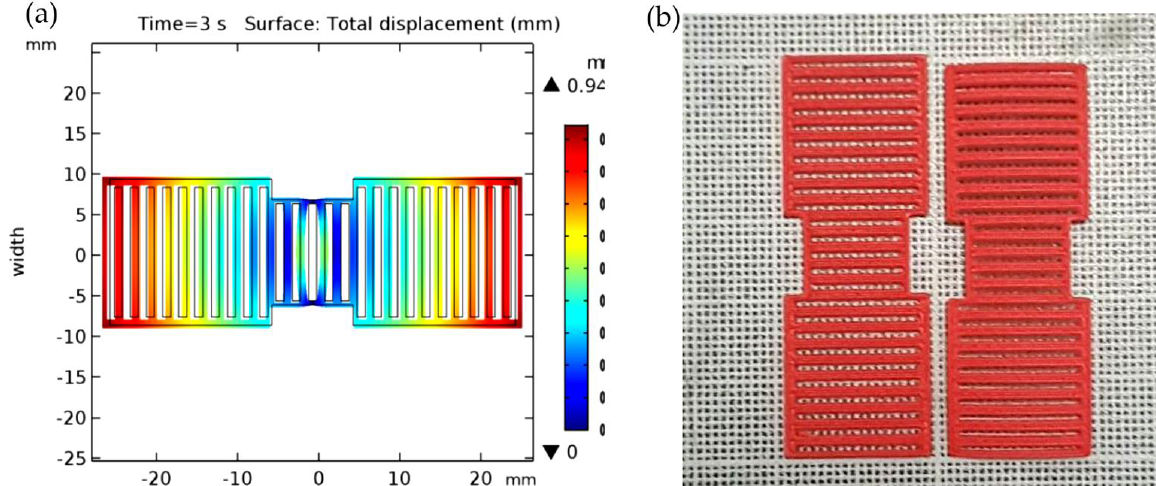
Figure 11. ( a ) PLA model deformation after 3 s. Uniformed vertical hollow spaces in 1 mm width. ( b ) Side by side comparison before and after adding stimulus. Left: a PLA model before adding stimulus and right: after adding the stimulus. Adapted from Alief et al. [177] with copyright permission of AIP Conference Proceedings.